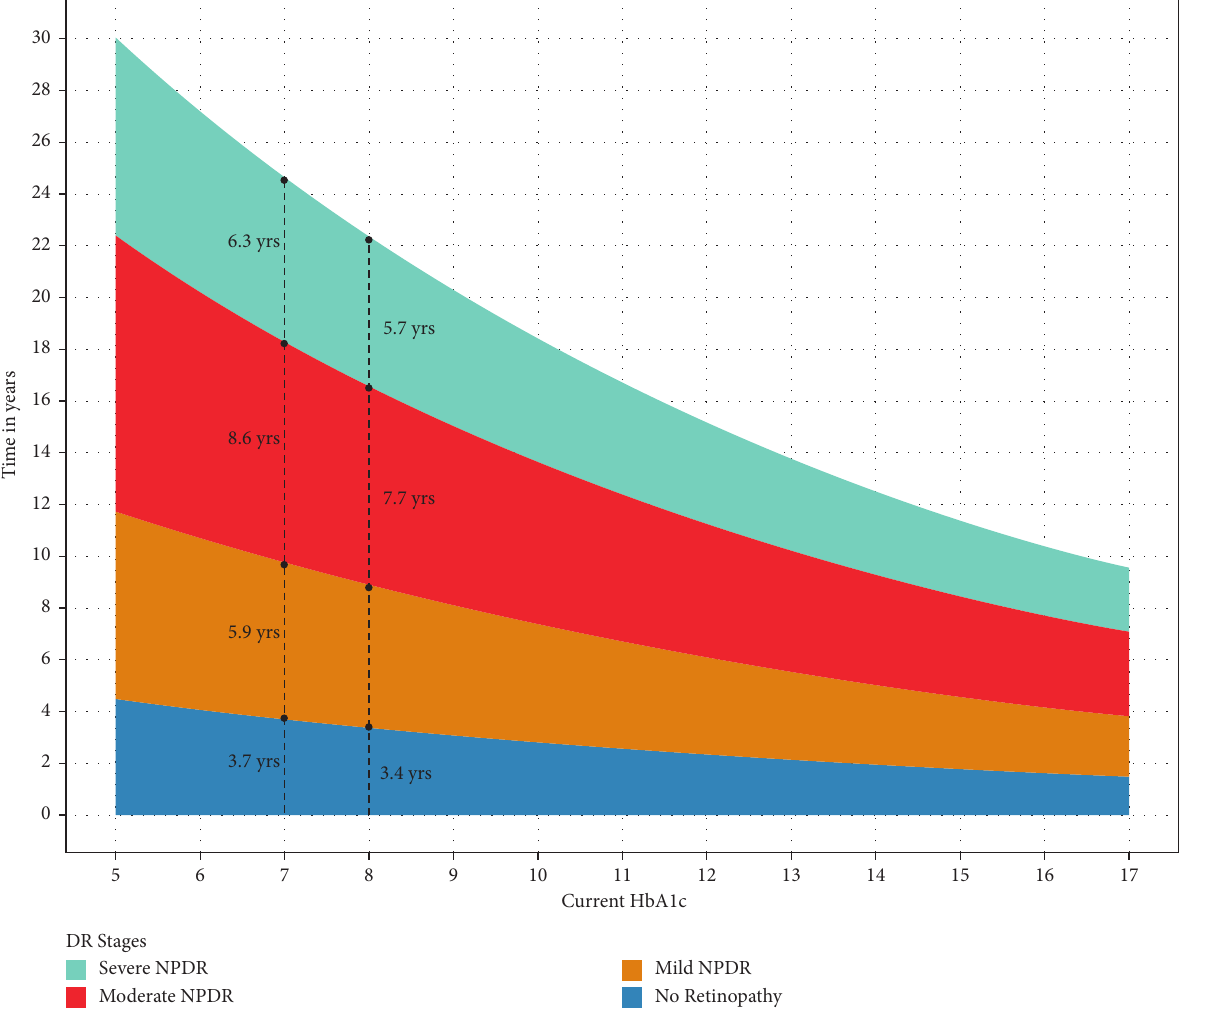
Figure 1: Illustration of the effect of HbA1c level on sojourn time, the expected time for a patient to progress to the next DR stage. For example, in our model, a patient who has mild NPDR with an HbA1c level of 7% is expected to progress to moderate NPDR in 5.9years, while another patient who has mild NPDR with an HbA1c level of 8% is expected to progress to moderate NPDR in 5.4years. DR � diabetic retinopathy; NPDR � nonproliferative diabetic